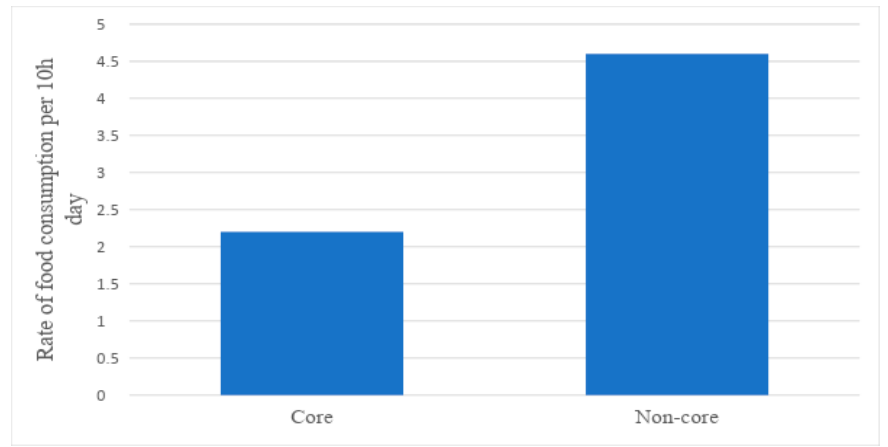
Figure 1. Mean rates of total core and non-core food consumption per 10 h day.